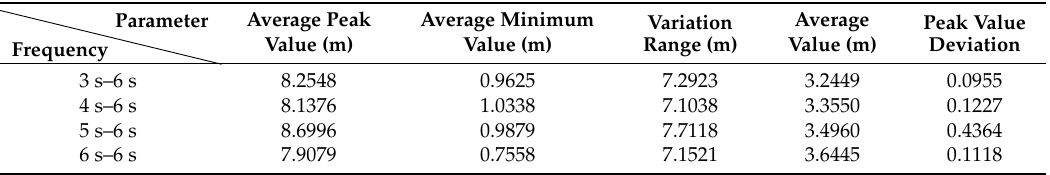
Table 6. Pressure values and statistical analysis after air inflow has been cut off for 6 s (rectangular nozzle on top of the pipe).